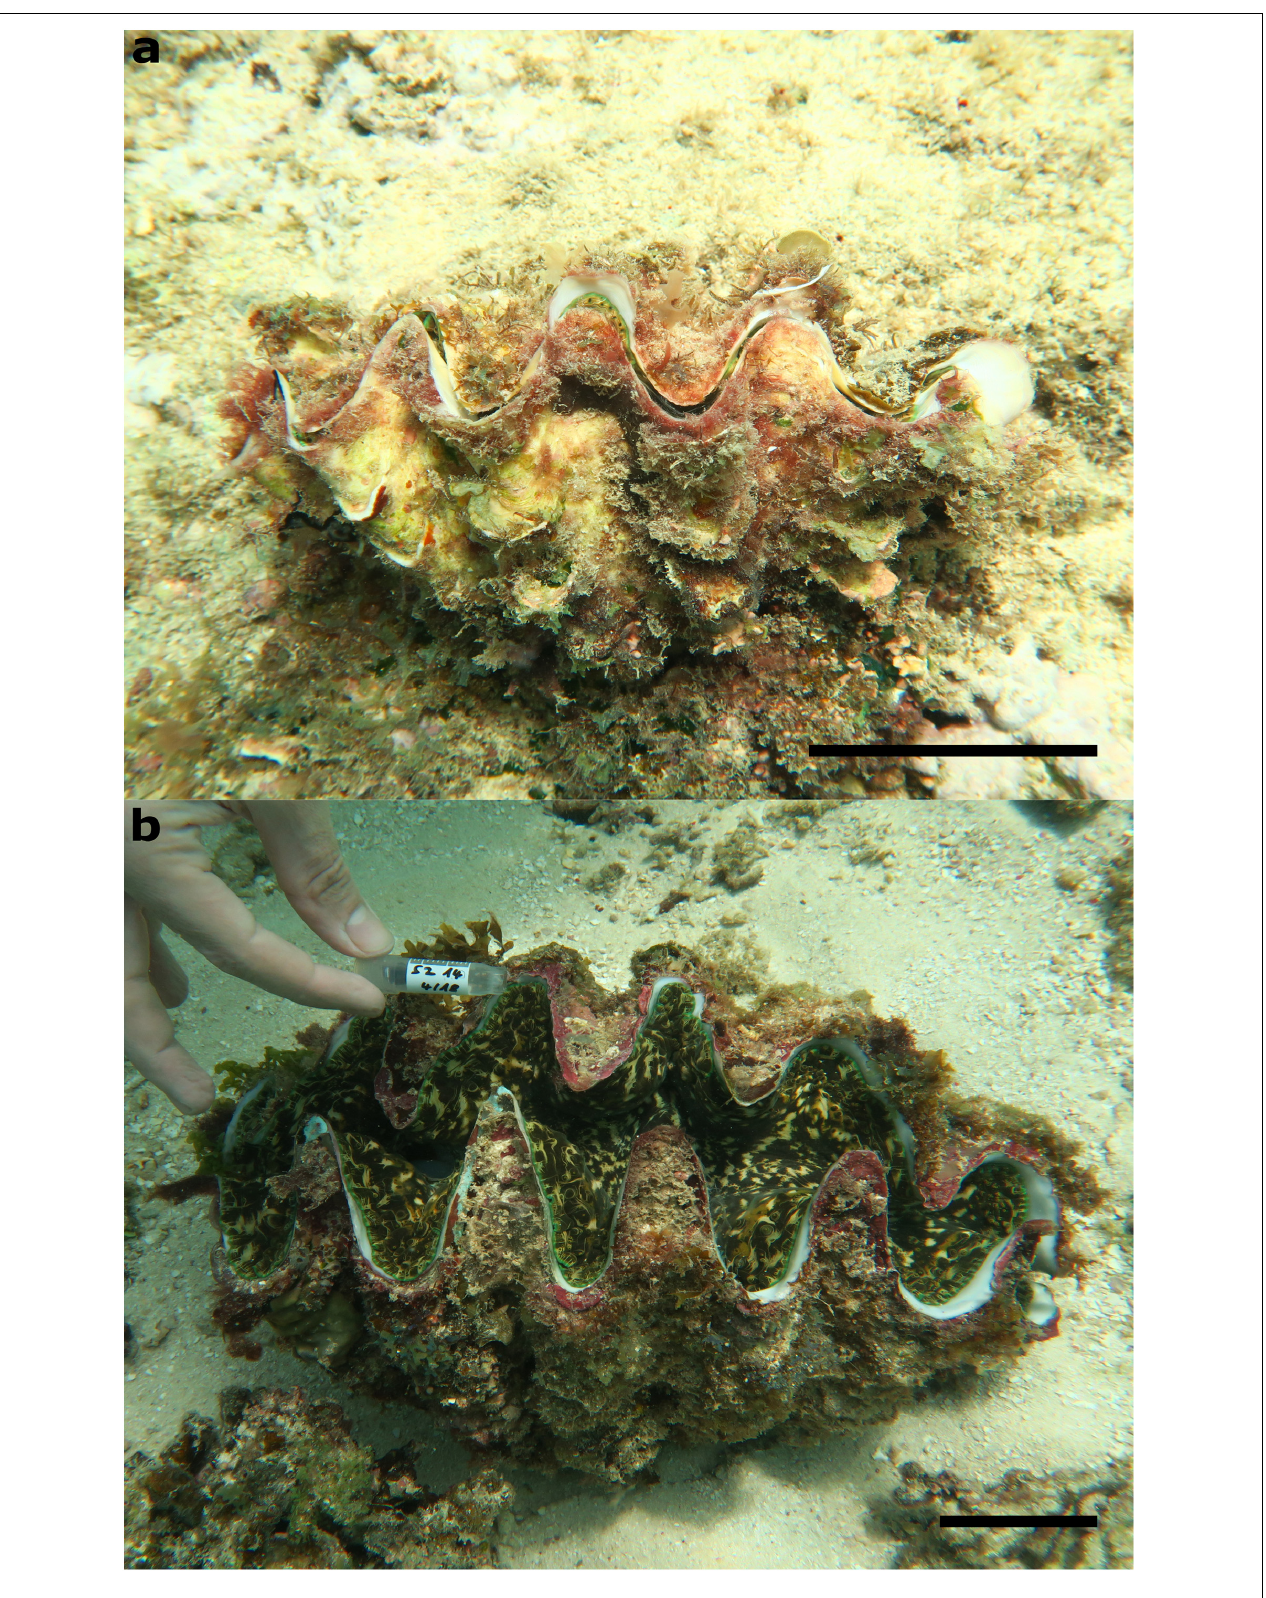
FIGURE 1 | Specimens of the (a) smallest and (b) largest T. squasomina specimens that were found in Farasan Banks. Scale bar = 5 cm.